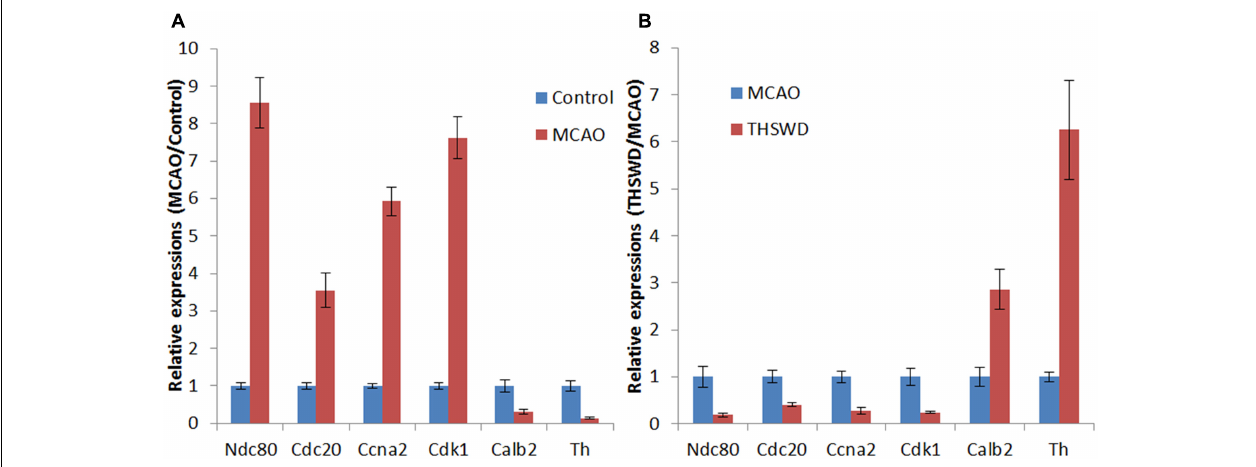
FIGURE 7 | Verification of DEGs by qRT-PCR. Expression of six genes in brain tissues was detected by qRT-PCR, and shown by the expression fold changes. GAPDH was used as the internal control. (A) presents the results of MCAO vs control, (B) presents the results of THSWD vs MCAO.